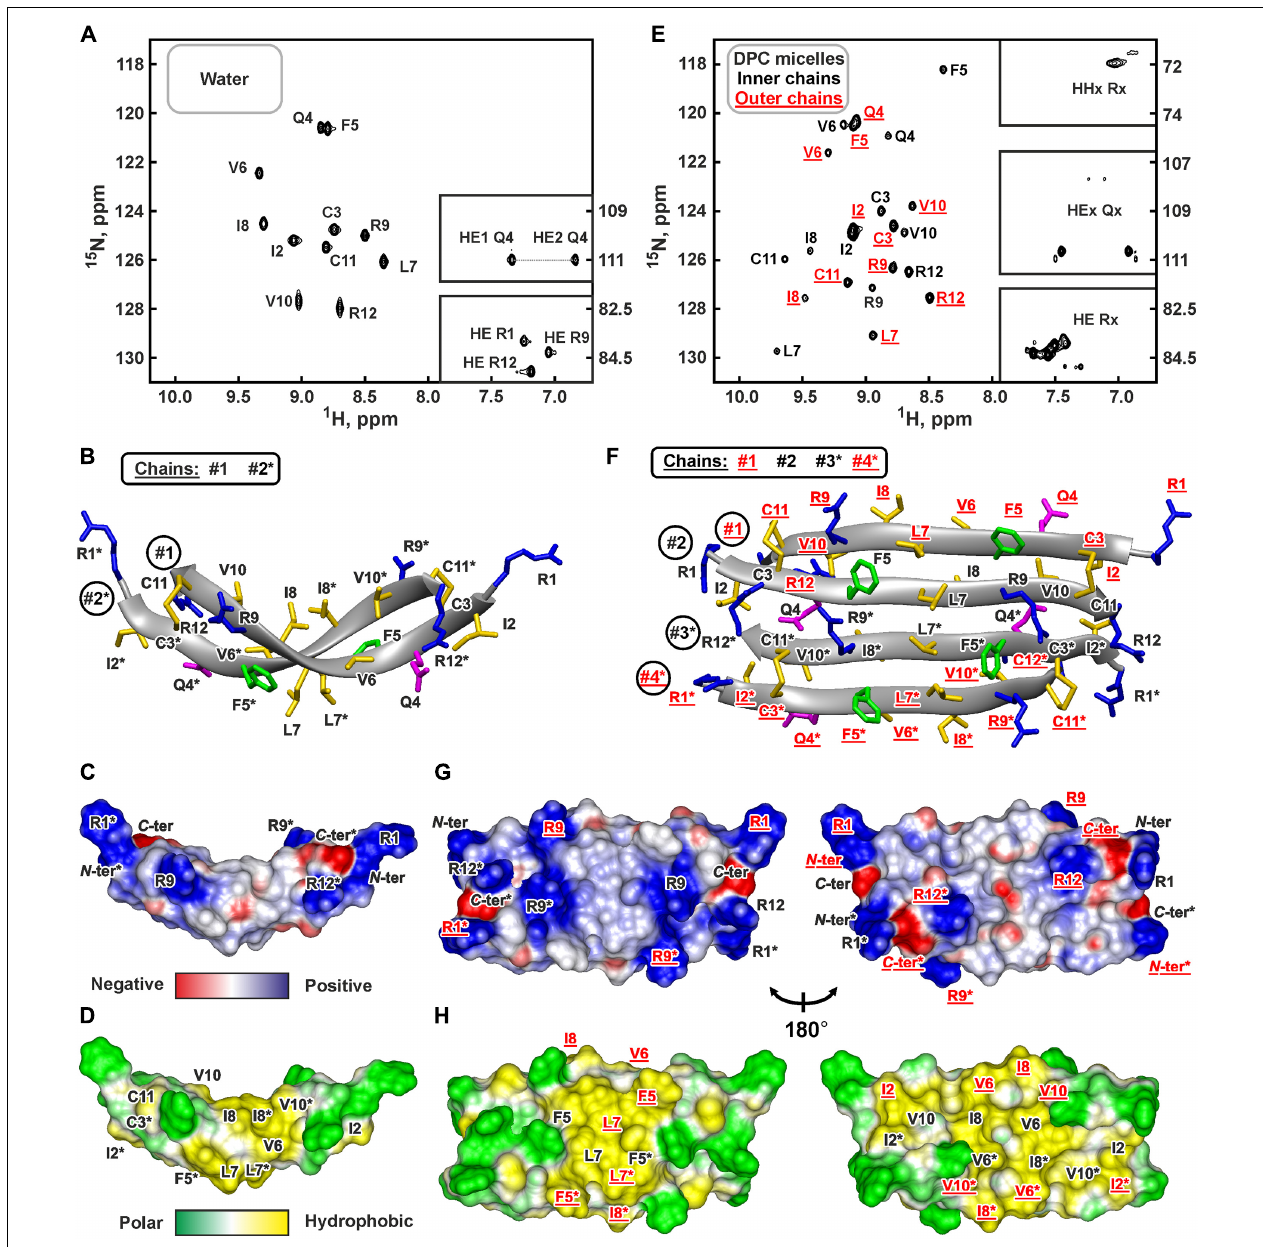
FIGURE 4 | NMR data defines 3D structure of the ChDode dimer in water (A–D) and of the ChDode tetramer in DPC micelles (E–H) . (A,E) 2D 1 H- 15 N sensitivity enhanced HSQC spectra of 0.4 mM 15 N-labeled ChDode covalent dimer in water (pH 4.0, 30 ◦ C, 600 MHz, 2,048 × 128 data points, 16 × 24 ppm spectral width) and in DPC micelles (pH 4.0, 40 ◦ C, 800 MHz, 2,048 × 64 data points, 15 × 15 ppm spectral width, dimer-to-lipid molar ratio, D : L = 1:130). The obtained resonance assignments are shown. The resonances of side chain groups are shown in the inserts. Assignment of the resonances from the outer chains of the ChDode tetramer in DPC is shown in red and underlined. (B,F) The representative conformers of ChDode in water and DPC micelles in ribbon representation. The positively charged, aromatic, and polar residues are colored in blue, green, and magenta, respectively. Disulfide bonds and hydrophobic residues are colored in yellow. The chains of the dimer and tetramer are numbered. The residues from the second peptide chains of the ChDode dimers in water and DPC are denoted by asterisks. The residues from the outer chains of the ChDode tetramer in DPC is shown in red and underlined. (C,D,G,H) Electrostatic and molecular hydrophobicity (Pyrkov et al., 2009) potentials are shown on the molecular surfaces of the ChDode dimer in water (C,D) and the ChDode tetramer in DPC micelles ( G,H , two-sided view). Red, blue, green, and yellow areas denote negative, positive, polar, and hydrophobic regions, respectively.